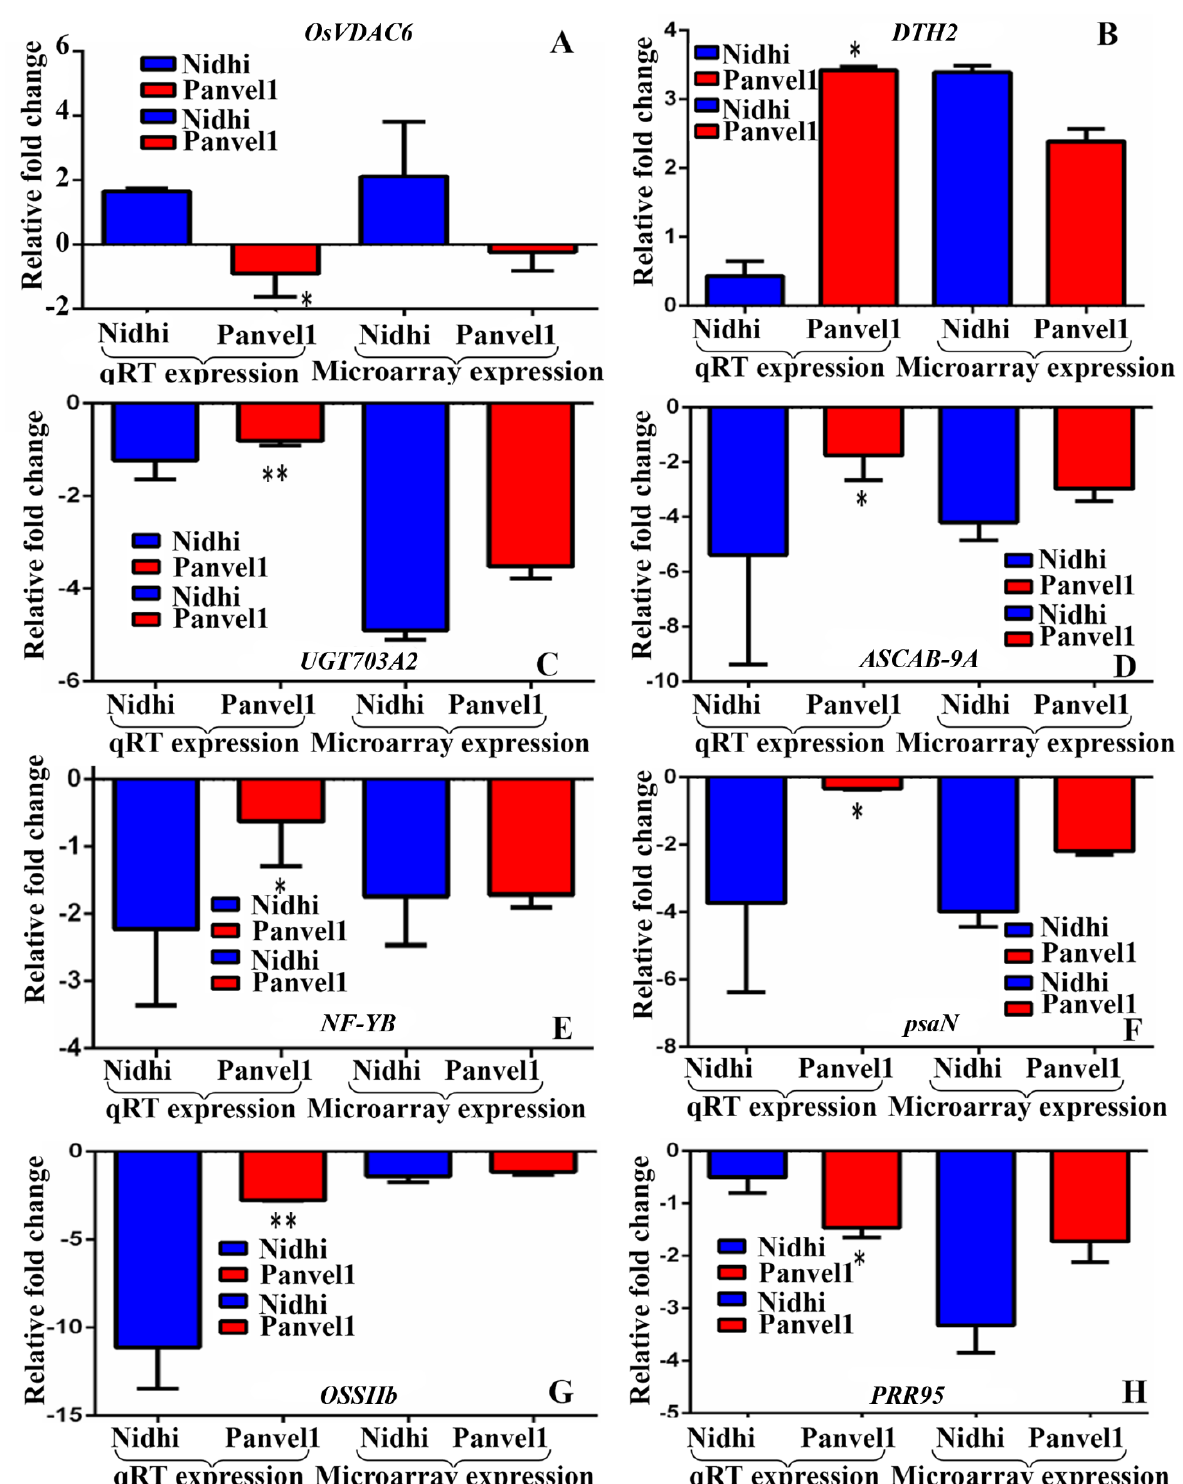
Figure 2. Validation of expression profile of urea-responsive genes by RT − qPCR. Relative change in the gene expression was calculated by comparative Ct value method and actin gene was used for data normalization. The control values were taken as zero and the test values are shown as average of three technical and two independent biological replicates (+SE). Each sub − figure compares gene expression of RT − qPCR and microarray for Nidhi versus Panvel1 for gene OsVDAC6 ( A ), DTH2 ( B ), UGT703A2 ( C ), ASCAB-9A ( D ), NF-YB ( E ), psaN ( F ), OSSIIb ( G ) and PRR95 ( H ). Test of significance between bars has been shown on RT − qPCR data of Nidhi versus Panvel1. * p < 0.05, ** p < 0.01.